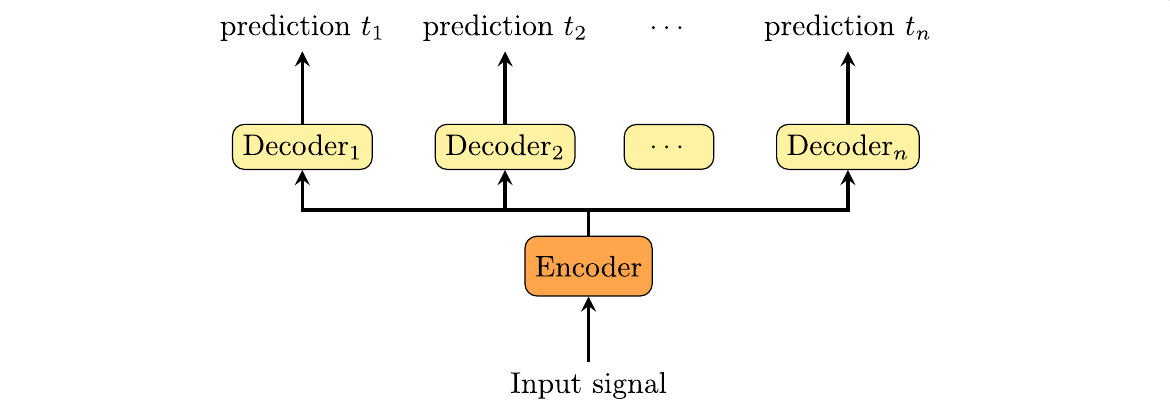
Fig. 1 Illustration of multi-task architecture. The output of the encoder is given to each decoder to produce the prediction for each t i